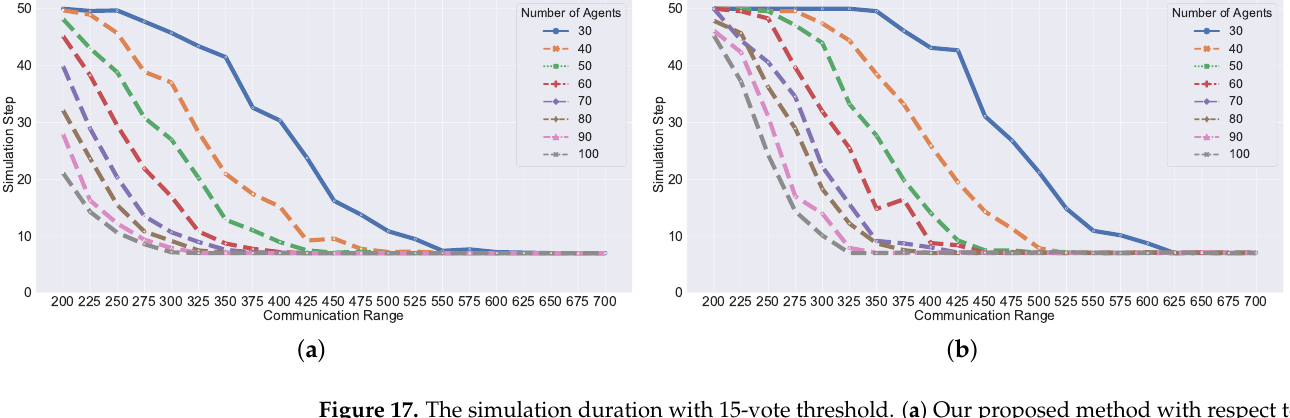
Figure 17. The simulation duration with 15-vote threshold. ( a ) Our proposed method with respect to different swarm size. ( b ) The Raft-based method with respect to different swarm